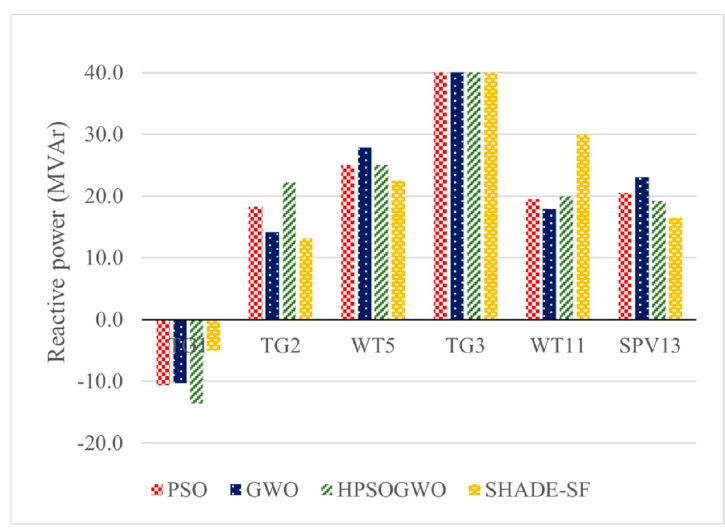
Figure 22. Generators reactive powers comparison (Case 4).